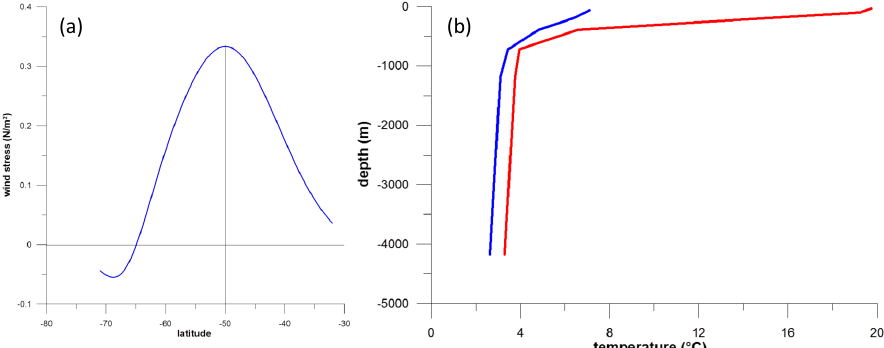
Fig. 3. (a) Steady zonal wind stress profile used to force the circulation model. (b) Initial stratifications (red/blue line: temperature profile at the northernmost/southernmost latitude).